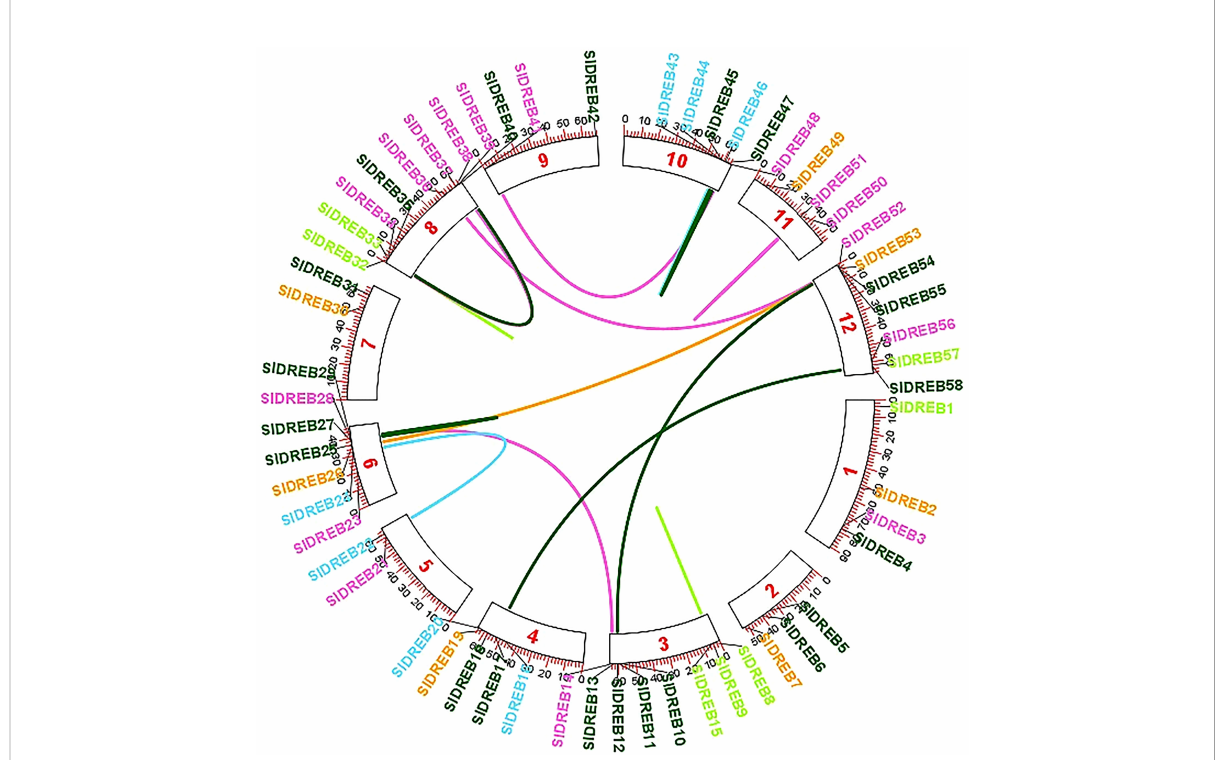
FIGURE 5 Segmental gene duplications were exhibited on the Circos plot of 58 SlDREB genes that was generated by the respective positions of each gene across 12 chromosomes. Colored lines indicated the segmental gene duplications among gene pairs situated on different